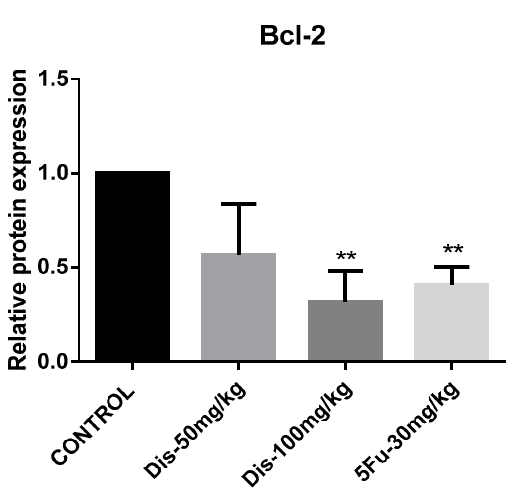
Figure 5. Dis altered apoptosis markers. Western blot analysis was carried out to evaluate the protein expression levels of Bax and Bcl-2. Results indicate that 100 mg / kg of Dis induces apoptosis through activation of Bax and inhibition of Bcl-2. β -Actin served as a loading control. Data were expressed as mean ± standard deviation. ** p < 0.01, *** p < 0.001, indicate significant differences compared to control.